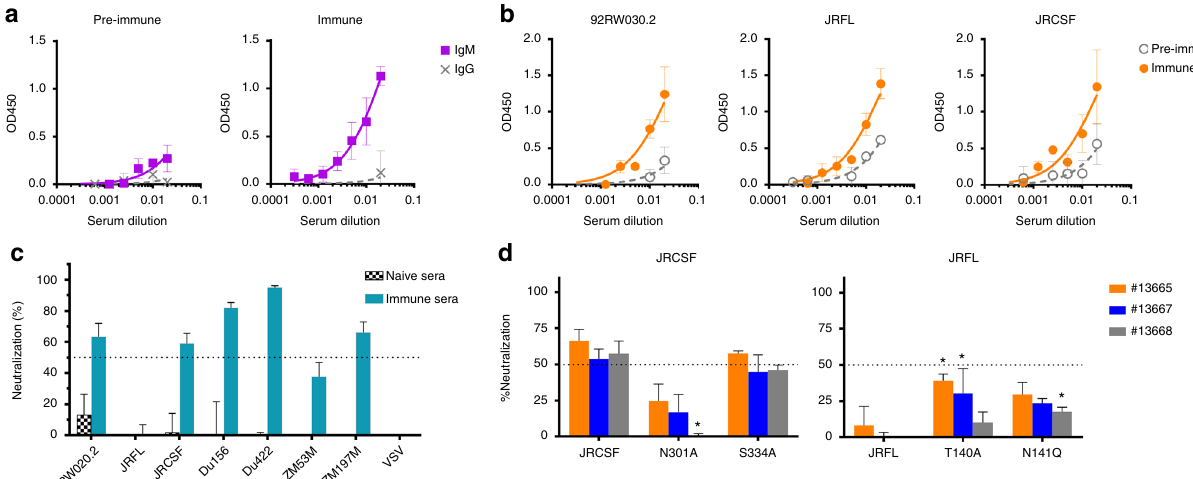
Fig. 6 Immunization with a bacterial mimic of oligomannose evokes HIV gp120-cross-reactive antibodies with tier 2 neutralizing activity in human-antibody transgenic OmniRats. Animals ( n = 3) were primed and then boosted (at day 21) with lead conjugate NIT82B formulated in the MF59-like adjuvant Addavax. Sera were collected 6 days thereafter. a Binding of IgM and IgG antibody in pre-immune and immune sera to biotinylated NIT82B (5 µ g ml − 1 ) in ELISA. b Comparison of pre-immune and immune serum IgM binding to solubilized HIV gp120 from viruses 92RW020.2, JRFL, and JRCSF. Graphs in a and b depict mean values for the three serum samples, with error bars denoting the error from the mean. c Heat-inactivated sera (1 h, 56 °C) from unimmunized and immunized animals ( n = 3 each) were assayed (1:10) against a panel of 7 (tier 2) subtype A, B, and C HIV strains and a VSV control virus. Results for the immune sera with the subtype A and B strains are from two independent experiments performed in duplicate or triplicate, while results for the immune sera with the subtype C strains are from a single experiment, performed in duplicate or triplicate. Results for the immune sera with VSV are from seven independent experiments, performed in duplicate or triplicate. Error bars represent the standard error from the mean. d Probing of the main serum speci fi city and factors hindering neutralizing activity. Each bar graph denotes the serum from each of the 3 immunized animals (orange: animal #13665; blue: animal #13667; grey: animal #13668). Left: Comparative assessment of serum neutralizing activity against JRCSF wild-type virus and mutant viruses N301A and S334A. Right: Serum neutralizing activity against JRFL wild-type virus to JRFL virus mutants with glycosylation sites missing in V1 (JRFL- T140A, JRFL-N141Q). The bars denote the mean with SEM from a single experiment performed in triplicate. * P < 0.05 (Kruskal – Wallis test with multiple